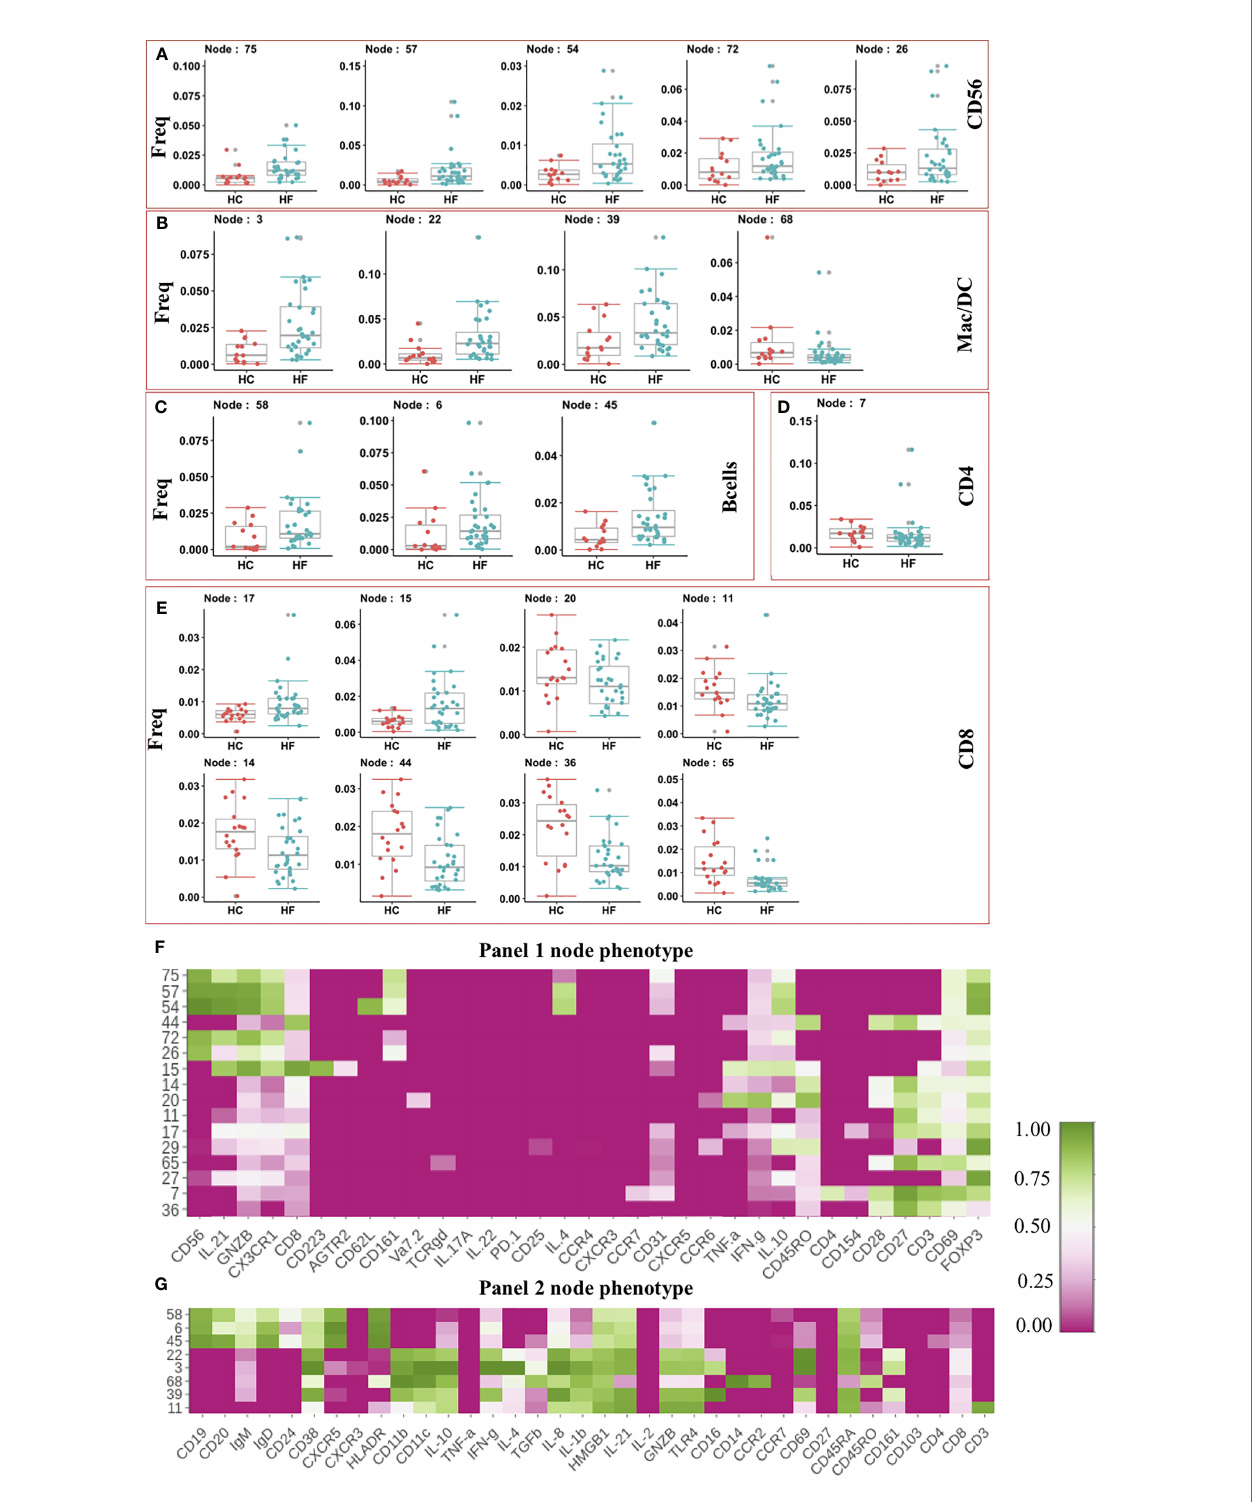
FIGURE 2 | (A – E) Frequency of modulated Immune cell subset in Heart Failure (HF n=32) patients compared to Healthy Controls (HC, n=18). Frequency of signi fi cantly altered cell subsets in heart failure (HF) cases when compared to healthy control (HC) were shown as box and whisker plots. Phenotypes of the immune cell subsets that are signi fi cantly altered in Heart Failure cases are shown as heatmap. Median intensity was scaled normalized for heatmap visualization. Heatmap shows phenotypes of nodes found signi fi cantly altered from Panel 1 CyTOF analysis (F) and Panel 2 CyTOF analysis (G)